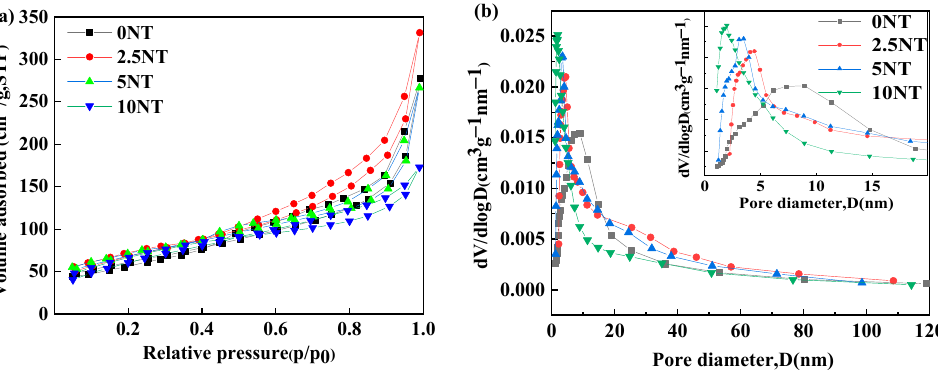
Figure 4. BET surface analysis of the samples. ( a ) Nitrogen adsorption–desorption isotherm curves; ( b ) Distribution of pore size. Table 1. BET measurement of the selected samples.